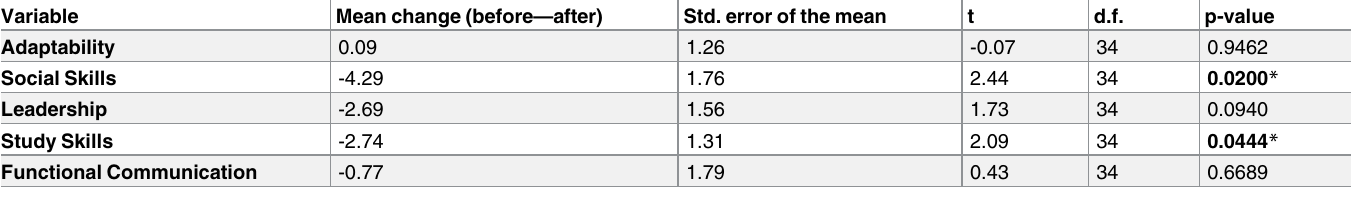
Table 3. Student’s paired t-test of the averagedifference in adaptive skills subcategory T scores for all participants (n = 35) before treatment vs. after treatment. Variable